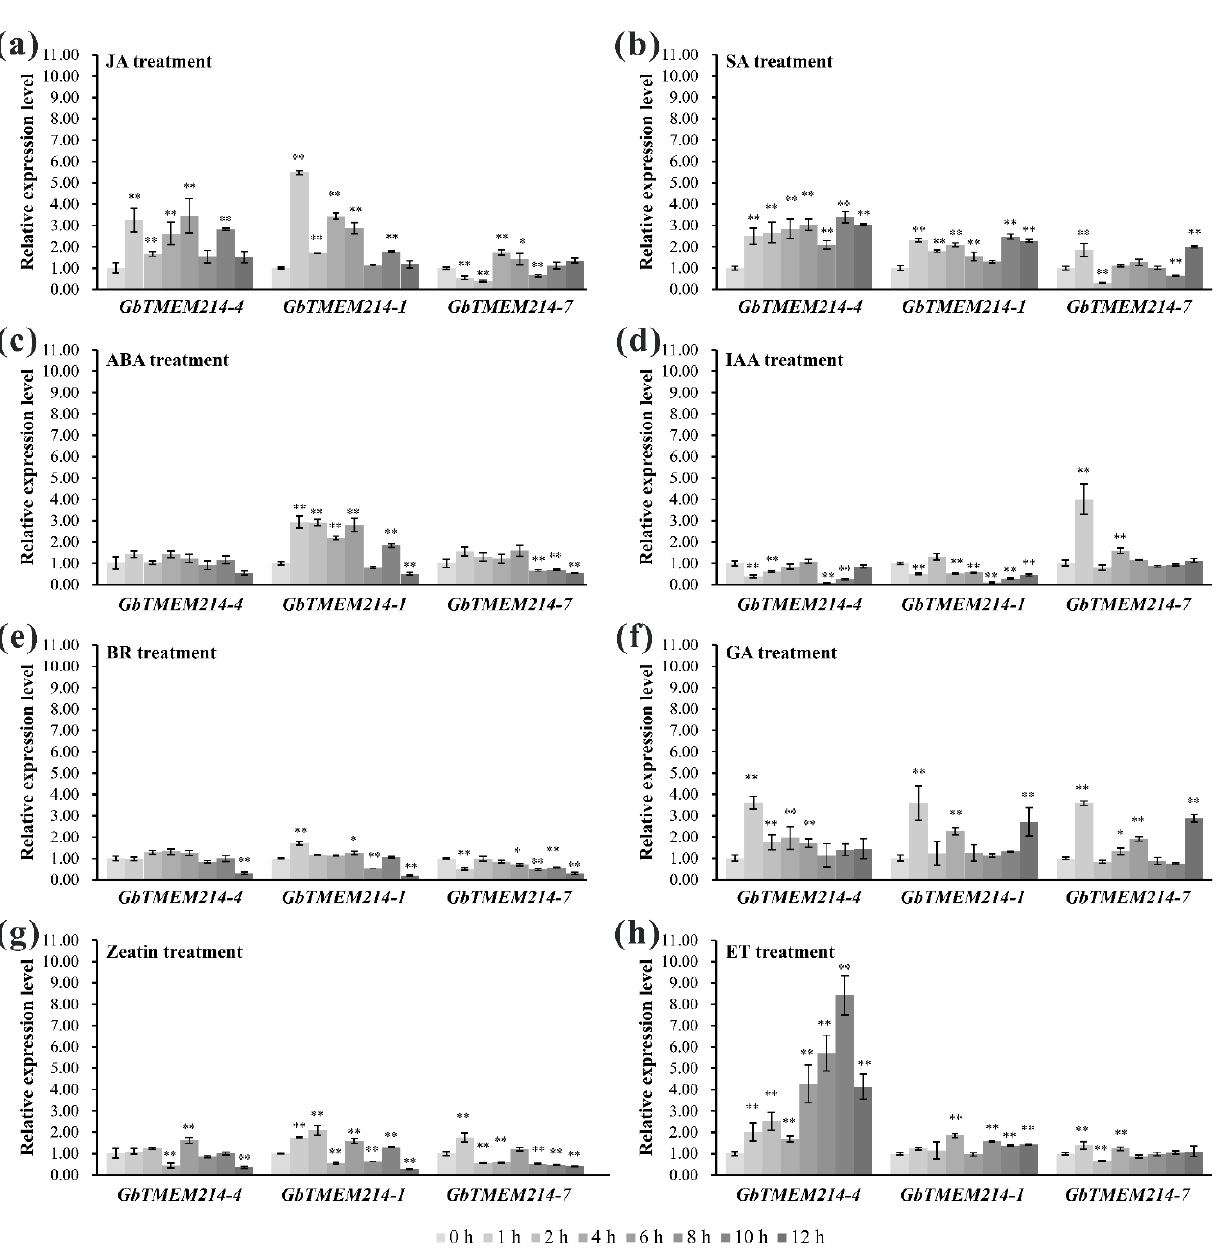
Figure 6. The relative expression levels of the GbTMEM214 genes with the treatment of phytohormone. ( a ) jasmonic acid (JA) treatment; ( b ) salicylic acid (SA) treatment; ( c ) abscisic acid (ABA) treatment; ( d ) indole-3-acetic acid (IAA) treatment; ( e ) brassinosteroid (BR) treatment; ( f ) gibberellin (GA) treatment; ( g ) zeatin treatment; ( h ) ethylene (ET) treatment. The qRT-PCR was applied to analyze the expression of the TMEM214 genes. The data were expressed relative to 0 h for each gene. “*”, “**” represent significant differences relative to each control and p -value < 0.05 or p -value < 0.01, based on Student’s t -test. Each value was the mean ± SD of three biological determinations.